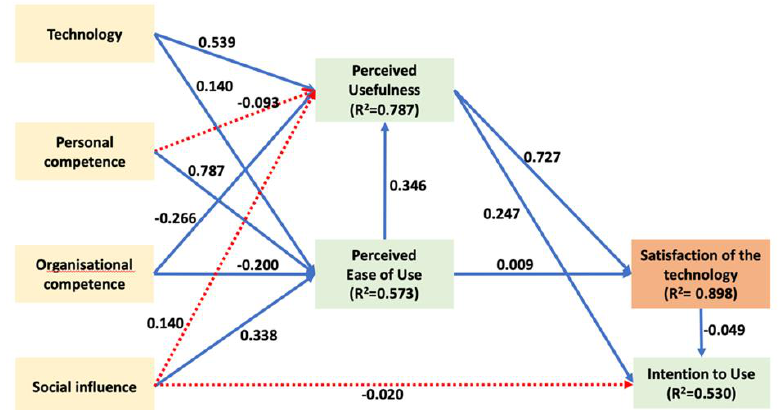
Figure 4. Results of hypothesis testing for large-sized enterprises.